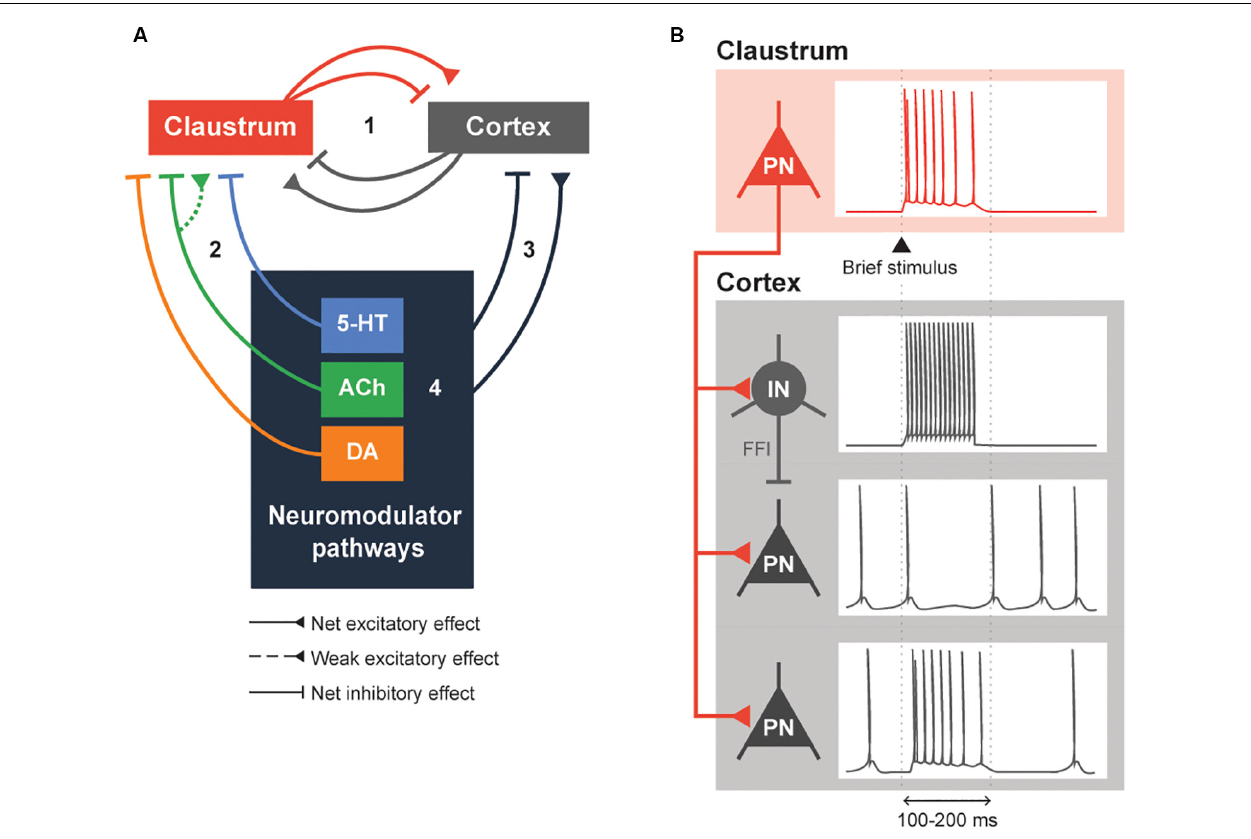
FIGURE 2 | Neuromodulation of the claustrocortical loop. (A) A simplified model consisting of the claustrum, the cortex and various neuromodulatory structures that release serotonin (5-HT), acetylcholine (ACh) and dopamine (DA). The claustrocortical loop (Pathway 1) consists of the claustrum and the cortex causing either a net excitation or inhibition of each other. Both the claustrum (Pathway 2) and cortex (Pathway 3) receive heavy input from the neuromodulator pathways. These neuromodulator pathways are also capable of regulating themselves (black box 4). (B) An illustration of claustrum input to the cortex. A claustral projection neuron (PN) receiving a brief stimulus will fire action potentials, which sends excitatory input into cortex. The cortical interneuron (IN) fires action potentials due to the excitation and subsequently inhibits the cortical PN. The cortical PN, receiving feed-forward inhibition through the cortical IN and excitation by the claustral PN, might initially fire action potentials and will remain silent during the period of inhibition by the cortical IN. Conversely, a subset of cortical PN will be directly excited by the claustral PN. These changes in cortical PN and IN activity would typically last for 100–200 ms or until claustral PN activity is